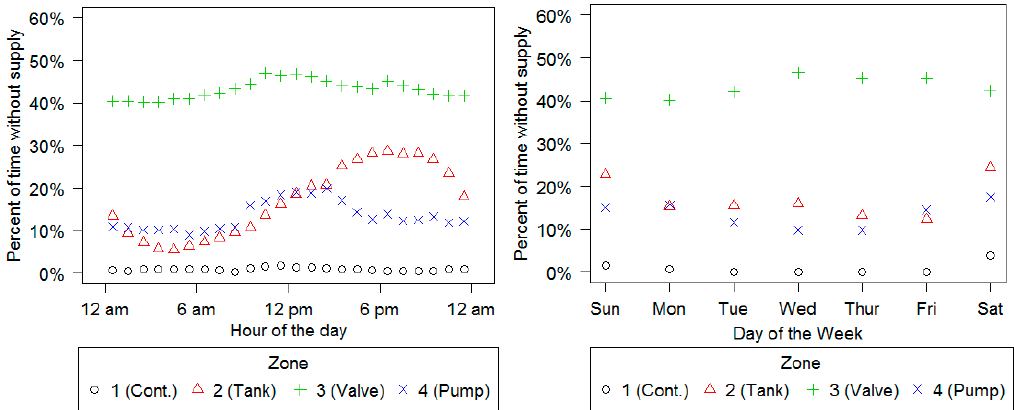
Figure 5. Percent of time each study zone was without supply by the hour of the day and day of the week.